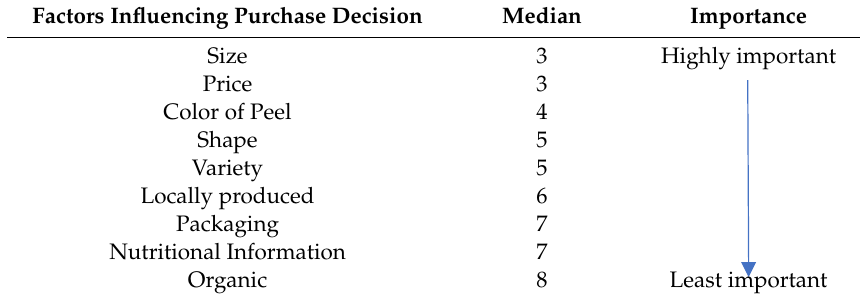
Table 2. Factors influencing purchase decision ( N = 95).